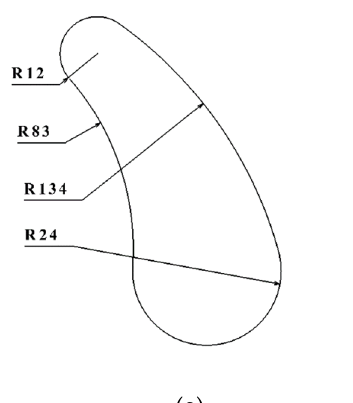
Figure 3. Bionic-pattern model: ( a ) schematic diagram of the bionic unit, the unit is mm; ( b ) struc- tural diagram of the bionic unit.